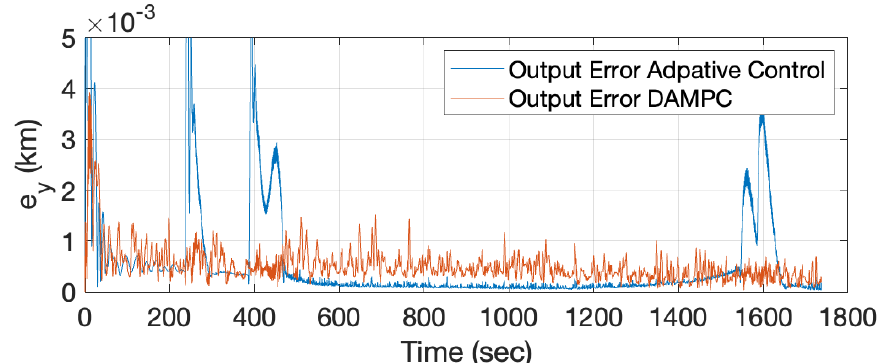
Figure 15. Zoomed-in output error magnitude for adaptive control and DAMPC.